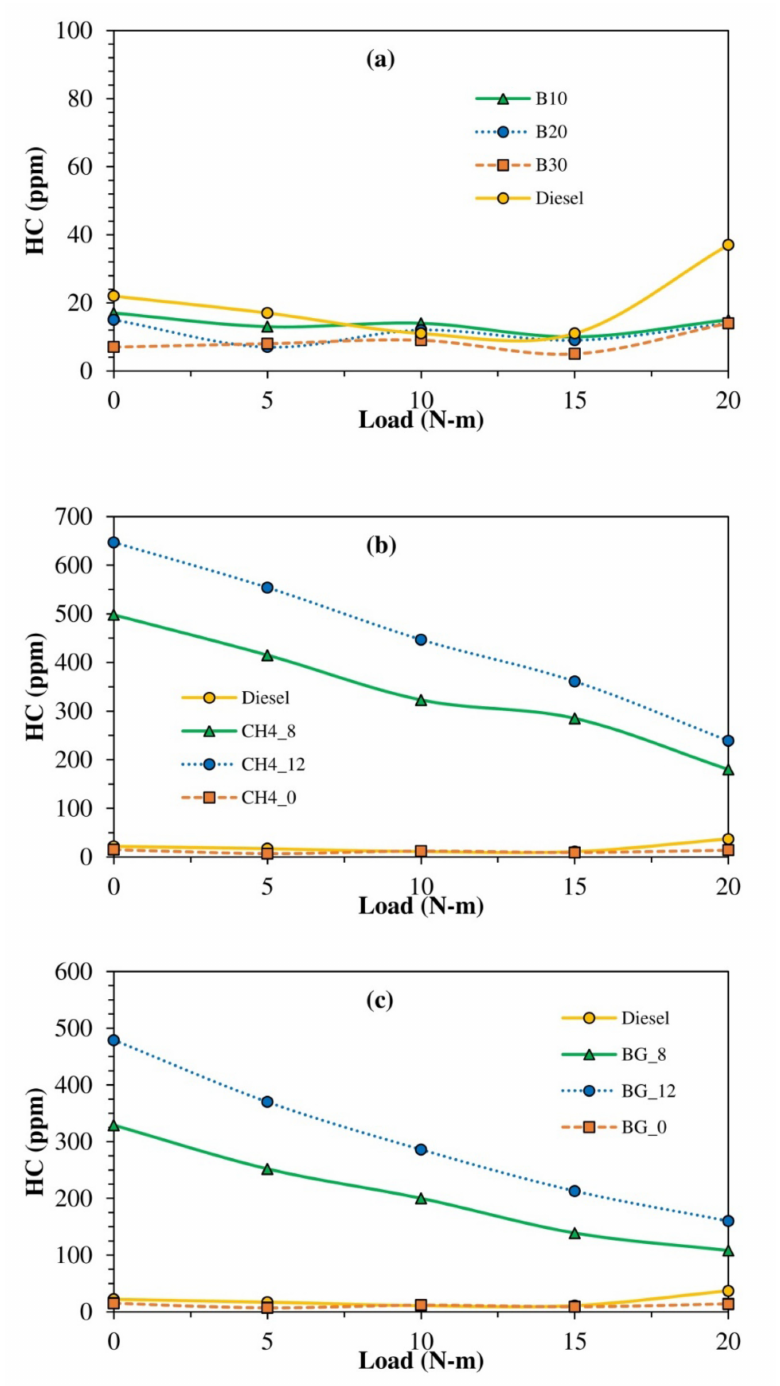
Figure 5. Variation of HC emissions with load at various ( a ) Mahua biodiesel blend, ( b ) methane flow rate and ( c ) biogas flow